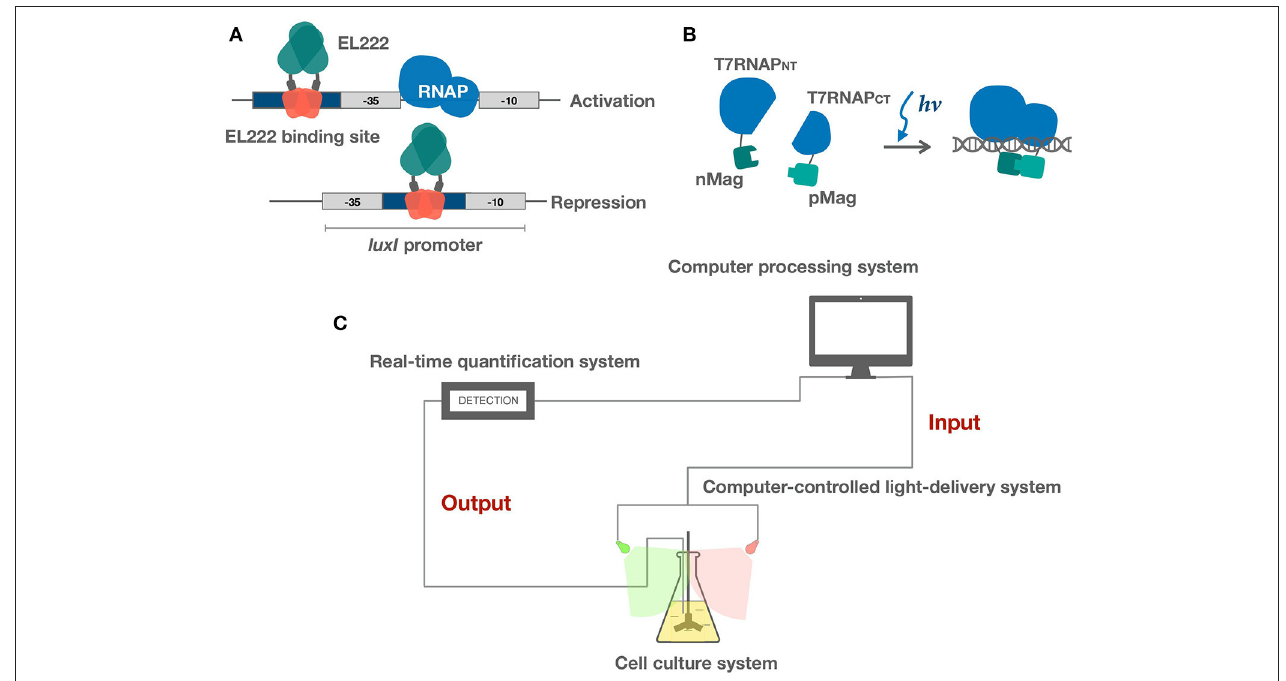
FIGURE 2 | Applications of light sensors in bacteria. (A) EL222 light-controlled bidirectional transcription system activates and represses gene expression via different binding strategies. (B) Split T7RNAP is brought together by Magnets, reconstituting its transcriptional activity. (C) Schematic of microbe-hardware interface and real-time feedback control system. Realtime feedback control is realized by algorithms and hardware. Hardware includes three modules: (1) a cell culture system (2) a real-time quantification system (3) a computer-controlled light-delivery system.